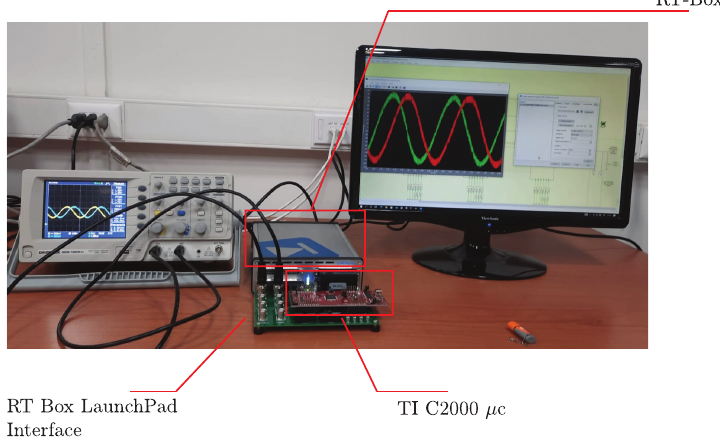
Figure 9. HIL validation setup.